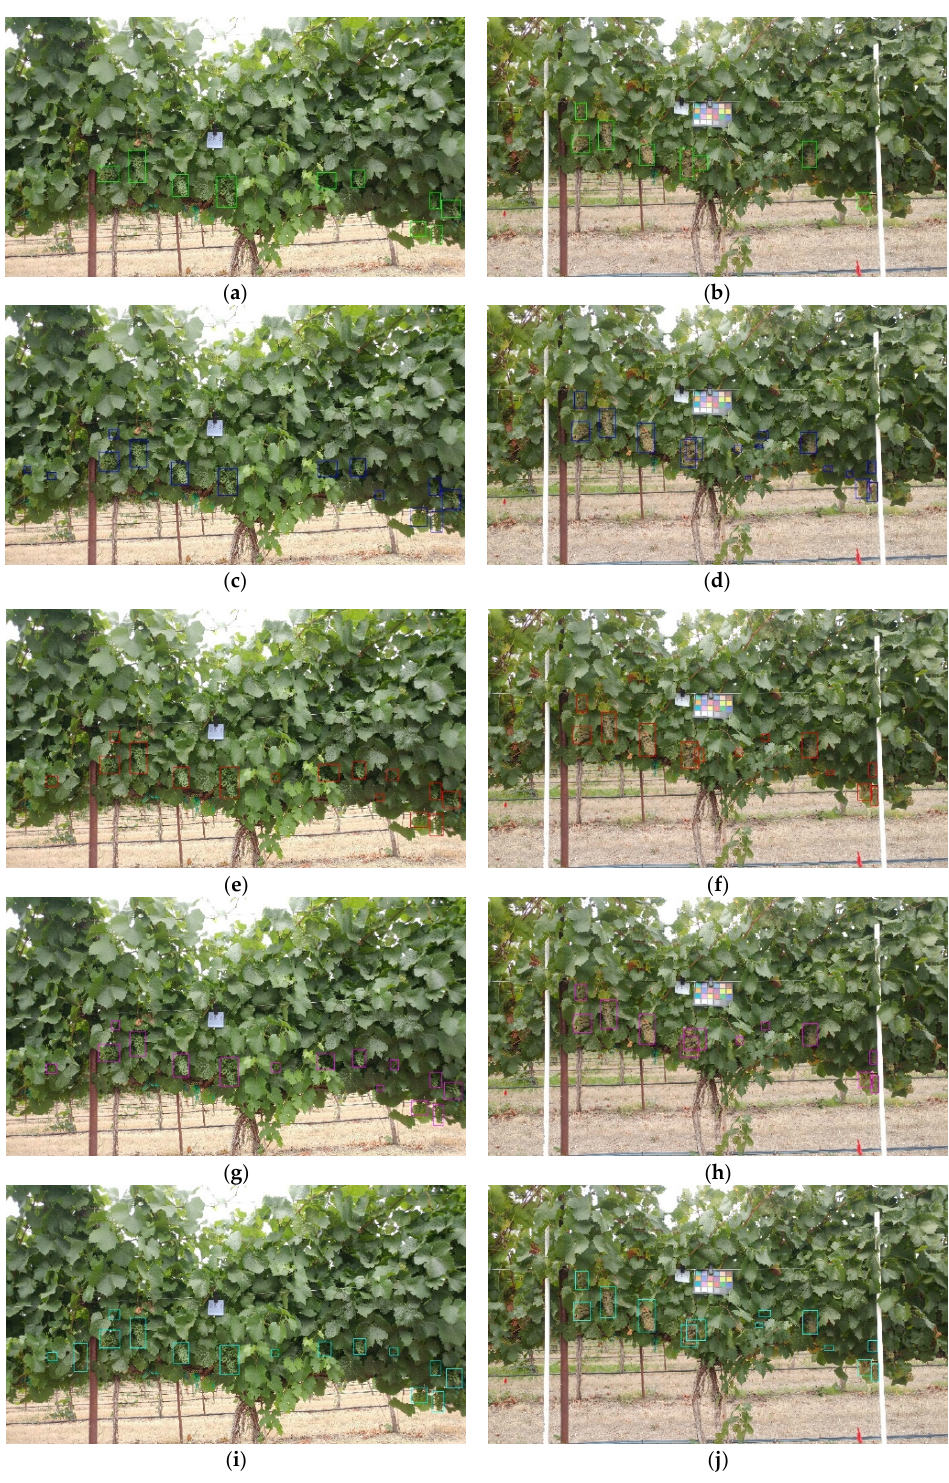
Figure A3. Demonstrations of detection results on the test set of Chardonnay (white variety) using ( a , b ) Faster R-CNN (bounding boxes in green color); ( c , d ) YOLOv3 (in blue color); ( e , f ) YOLOv4 (in red color); ( g , h ) YOLOv5 (in magenta color); and ( i , j ) Swin-transformer-YOLOv5 (in cyan color) at immature (left) and mature (right) stages.